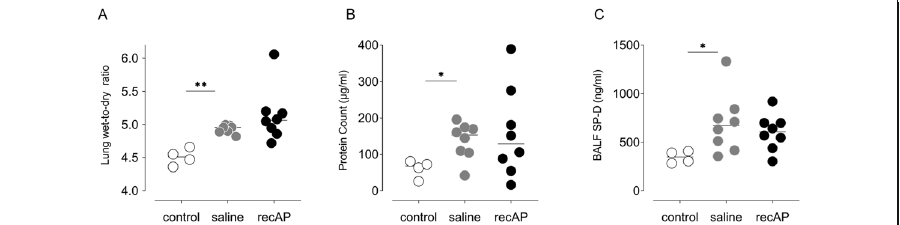
Fig. 6 Markers of endothelial and epithelial barrier dysfunction in the two-hit lung injury model in rats. a Lung wet-to-dry ratio. b Total protein count in BALF. c SP-D levels in BALF. Abbreviations: BALF, bronchoalveolar lavage fluid; recAP, recombinant alkaline phosphatase; SP-D, surfactant protein D. * p value < 0.05; ** p value <